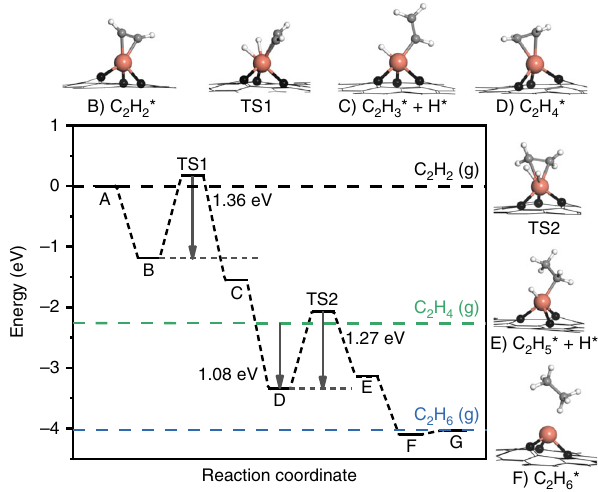
Fig. 5 Energy pro fi le of acetylene hydrogenation on the Cu 1 /ND@G catalyst and the structures of intermediates and transition states. Color code: Cu (orange), C in graphene (black), C in reactant/intermediates/product (gray), and H